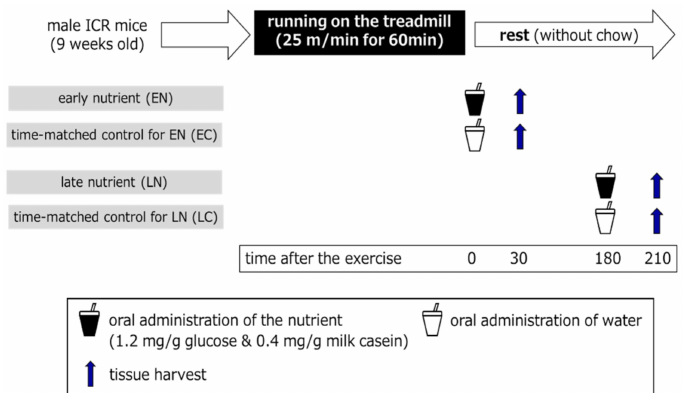
Figure 1. The design of experiment 2. Male ICR mice (9 weeks old) ran on a treadmill at 25 m / min for 60 min in a fed state. Mice were orally administered nutrients (early nutrient (EN), late nutrient (LN)) or water (EN group control (EC), LN group control (LC)) immediately after (EN, EC) or 180 min after (LN, LC) running. Tissues were harvested at 30 min after the oral administration. Chow was removed at 60 min before running to avoid a postprandial state and it was not provided during the post-exercise